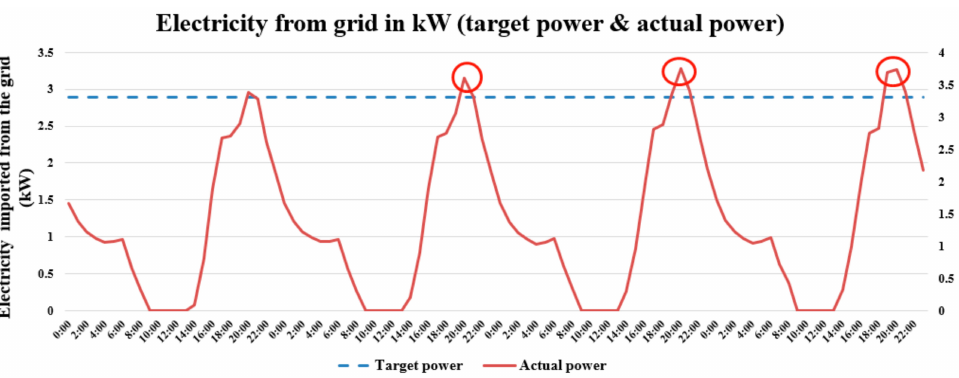
Figure 6. Electricity from grid in kW—example for excursion.